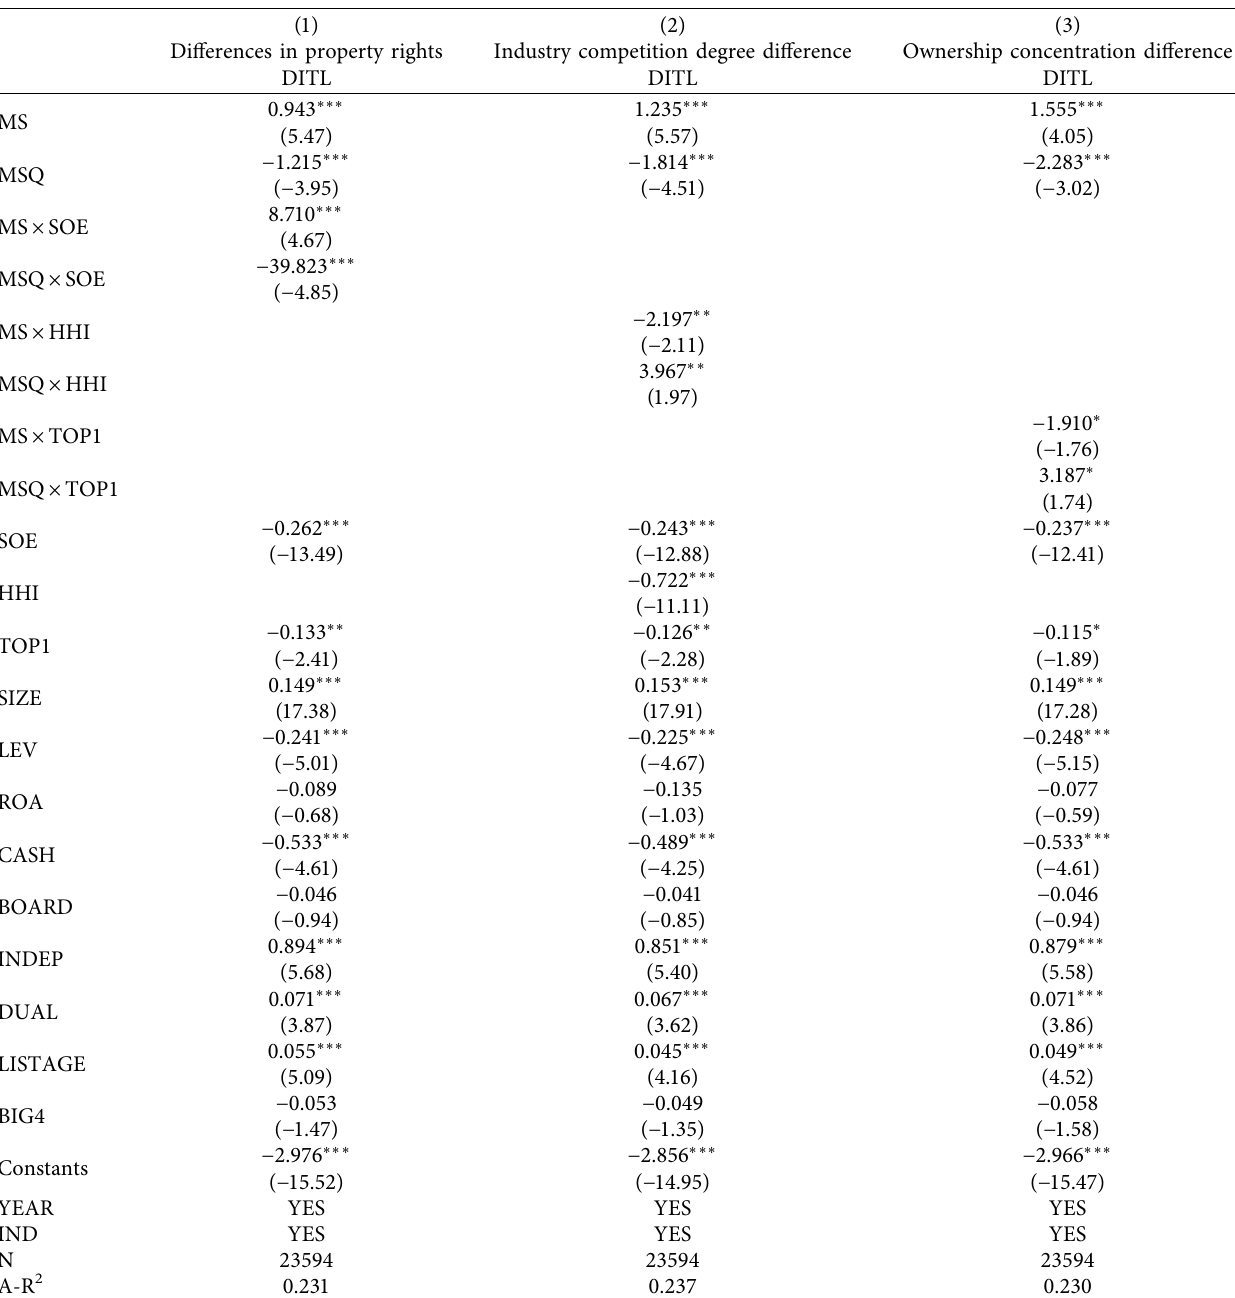
Table 4: Test results of moderating